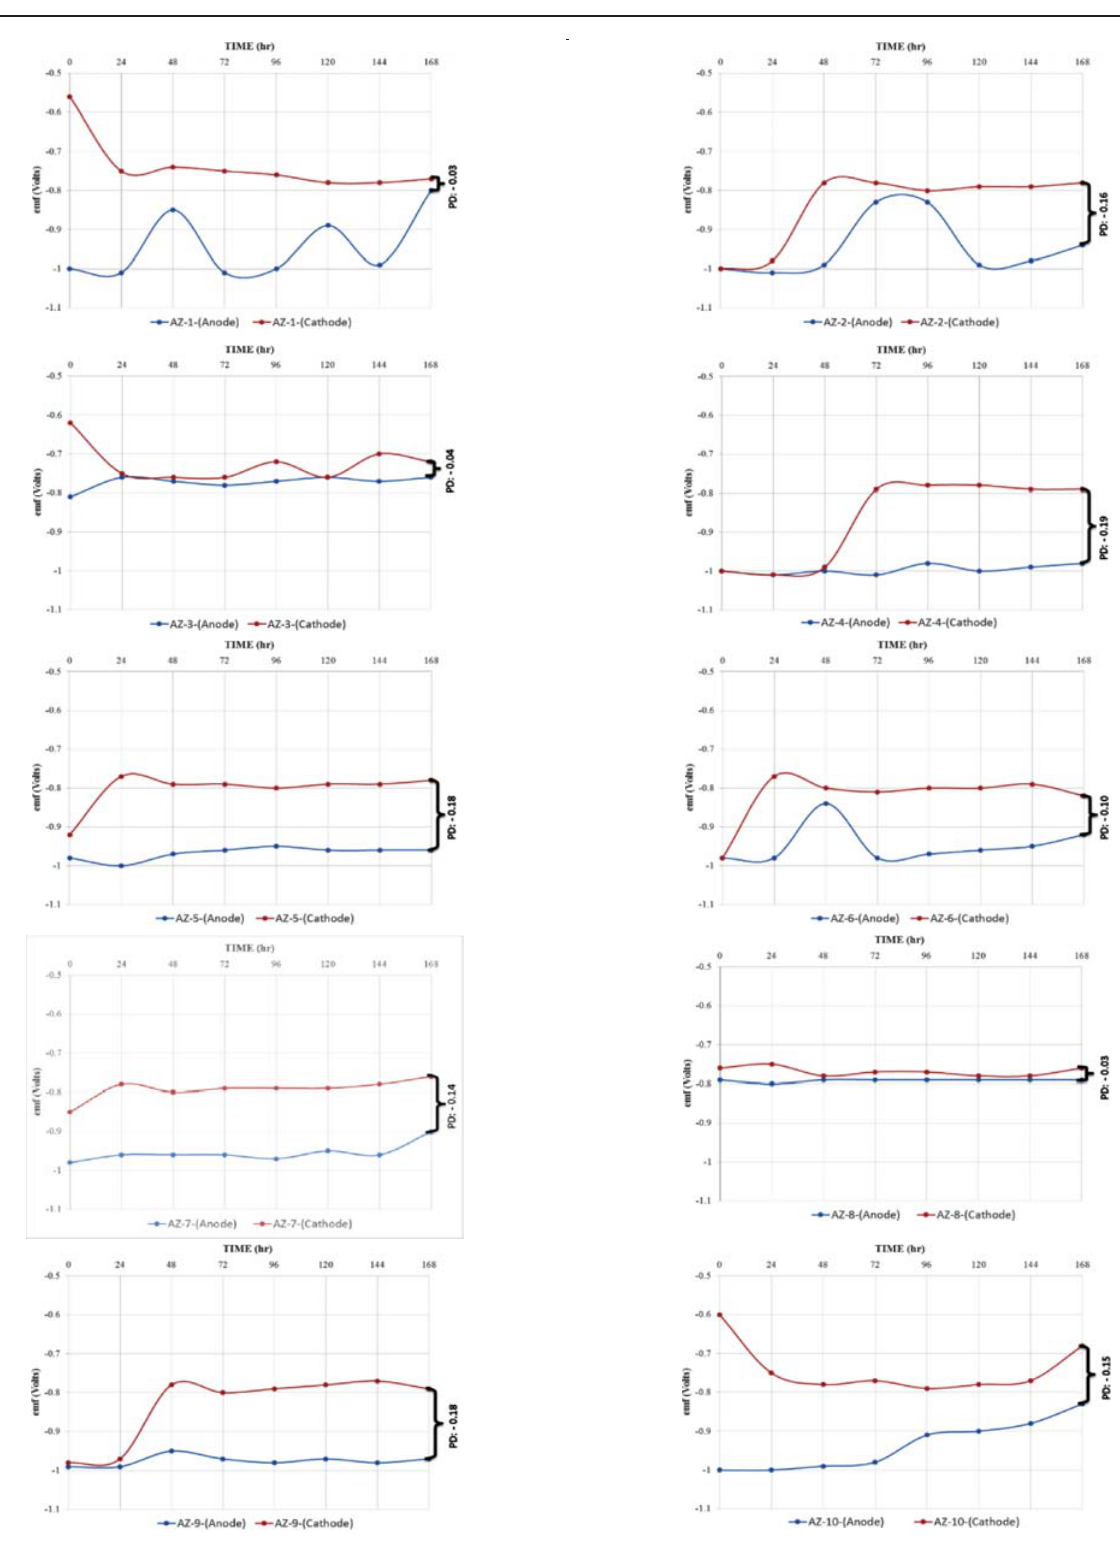
FIG. 5. TIME VS EMF CURVE BETWEEN EACH ANODE AND